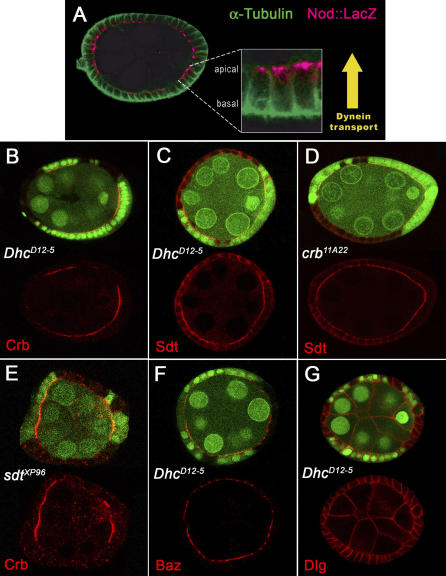
Loss of Dhc Disrupts the Apical Localization of Sdt and Crb(A) An anti-α-Tubulin antibody (green) reveals MTs in the FCs, while a nod::LacZ transgene (magenta) shows that the MT minus ends point toward the apical surface. Dynein is known to transport cargo toward MT minus ends.(B–G) Wild-type cells are marked with GFP (green) in mosaic egg chambers.(B) Crb is virtually absent in Dhc clones.(C) Sdt is largely missing from the apical surface in Dhc clones and is instead found throughout the cytoplasm. Mis-localization of Sdt in Dhc clones cannot be due solely to the loss of Crb, as crb clones consistently retain a punctate Sdt signal near the apical side of the cell (D). Mislocalization of Sdt in Dhc clones could account for the loss of Crb, however, as Crb is strongly disrupted in sdt clones (E).(F) Baz is only slightly reduced at the apical surface in Dhc cells.(G) Dlg localization is largely normal in Dhc clones.